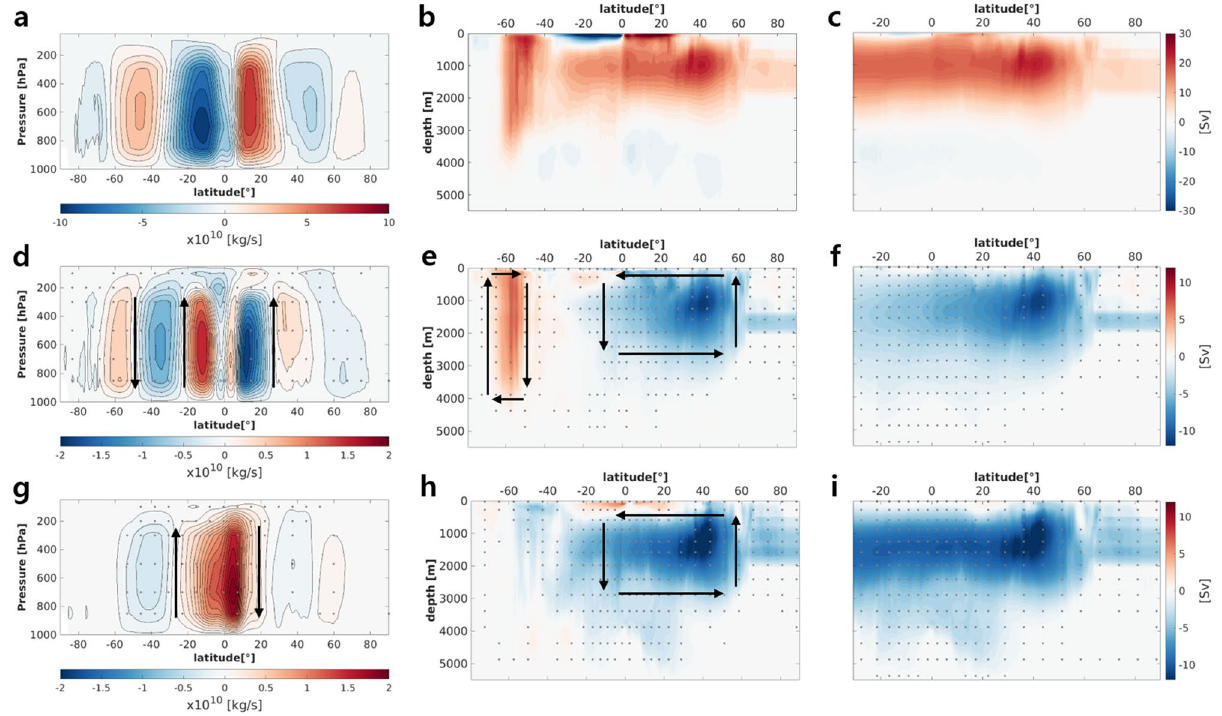
Figure 3. Vertical cross-section of annual-mean values for ( a ) atmospheric mean meridional circulation (MMC), ( b ) global meridional overturning circulation (MOC), and ( c ) Atlantic MOC obtained from PI experiment. ( d ) MMC, ( e ) global MOC and ( f ) AMOC for the ON50Y period as in ( a – c ), respectively, but for deviations from means of PI experiment. ( g – i ) as in ( d – f ), but for the OFF50Y. Units for the atmospheric MMC and oceanic MOC are 10 10 kg −1 and are Sv, respectively. Arrows indicate the direction of circulation. Dots indicate grids where the deviations are statistically significant with 99% confidence, as tested using the bootstrap